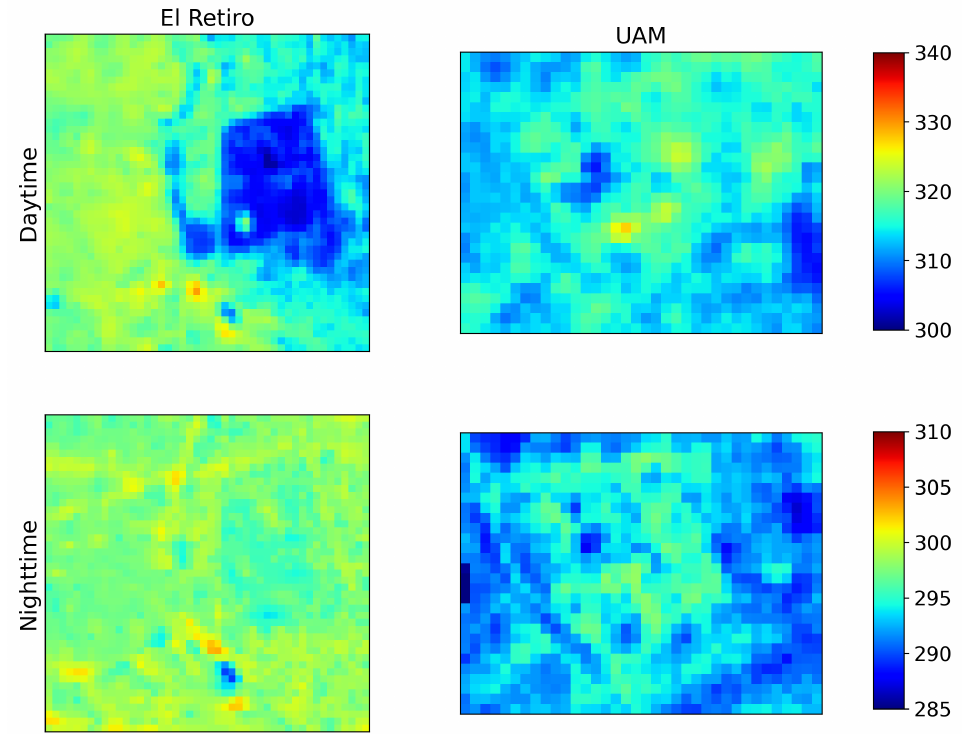
Figure 16. LST in K retrieved from the 2MMD-4-band TES over the Retiro Park ( left ) and the UAM ( right ) during the daytime ( top ) and nighttime ( bottom ). The RMSE values are between 1.25 and 2.5 K for both areas during the daytime and nighttime. The MBE values are − 0.62 K for the Retiro Park and − 0.42 K for the UAM for daytime. During the nighttime, the MBE values are higher, with − 1.51 K for the Retiro Park and − 1.61 K for the UAM. The SSIM values are not high, 0.59 for the Retiro Park